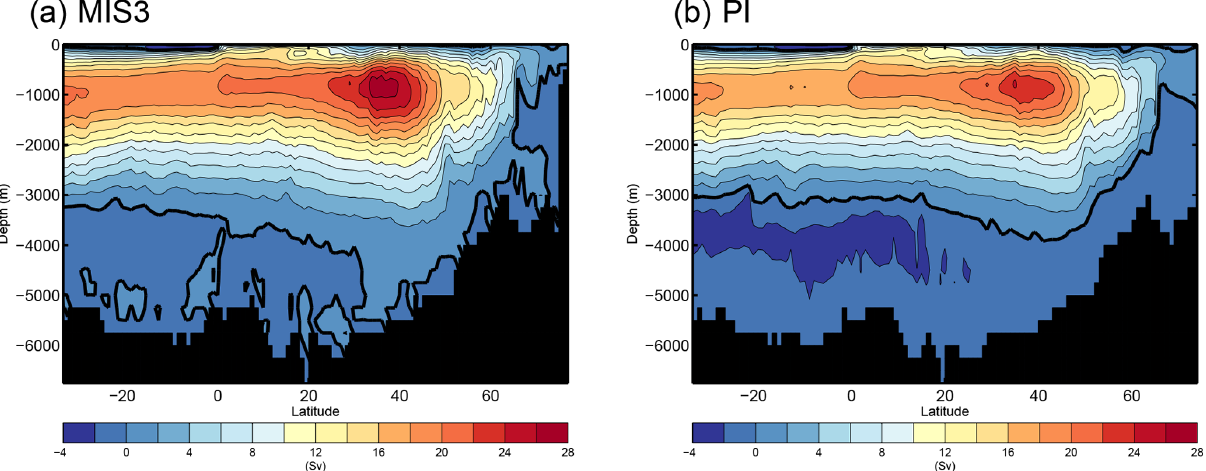
Figure 8. AMOC for (a) MIS3 and (b) PI simulations. The thick black line denotes the zero contour line.